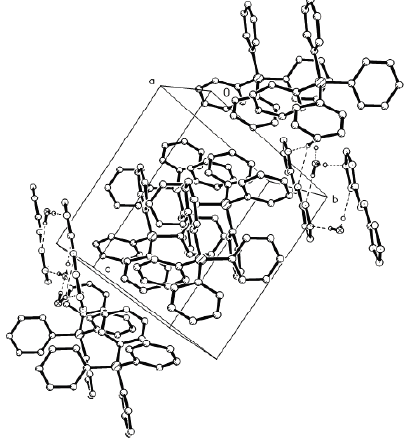
Figure 3. Packing diagram of tetraphenylphosphonium-5,5'-azotetrazolate ( 1 ). Dashed lines represent hydrogen